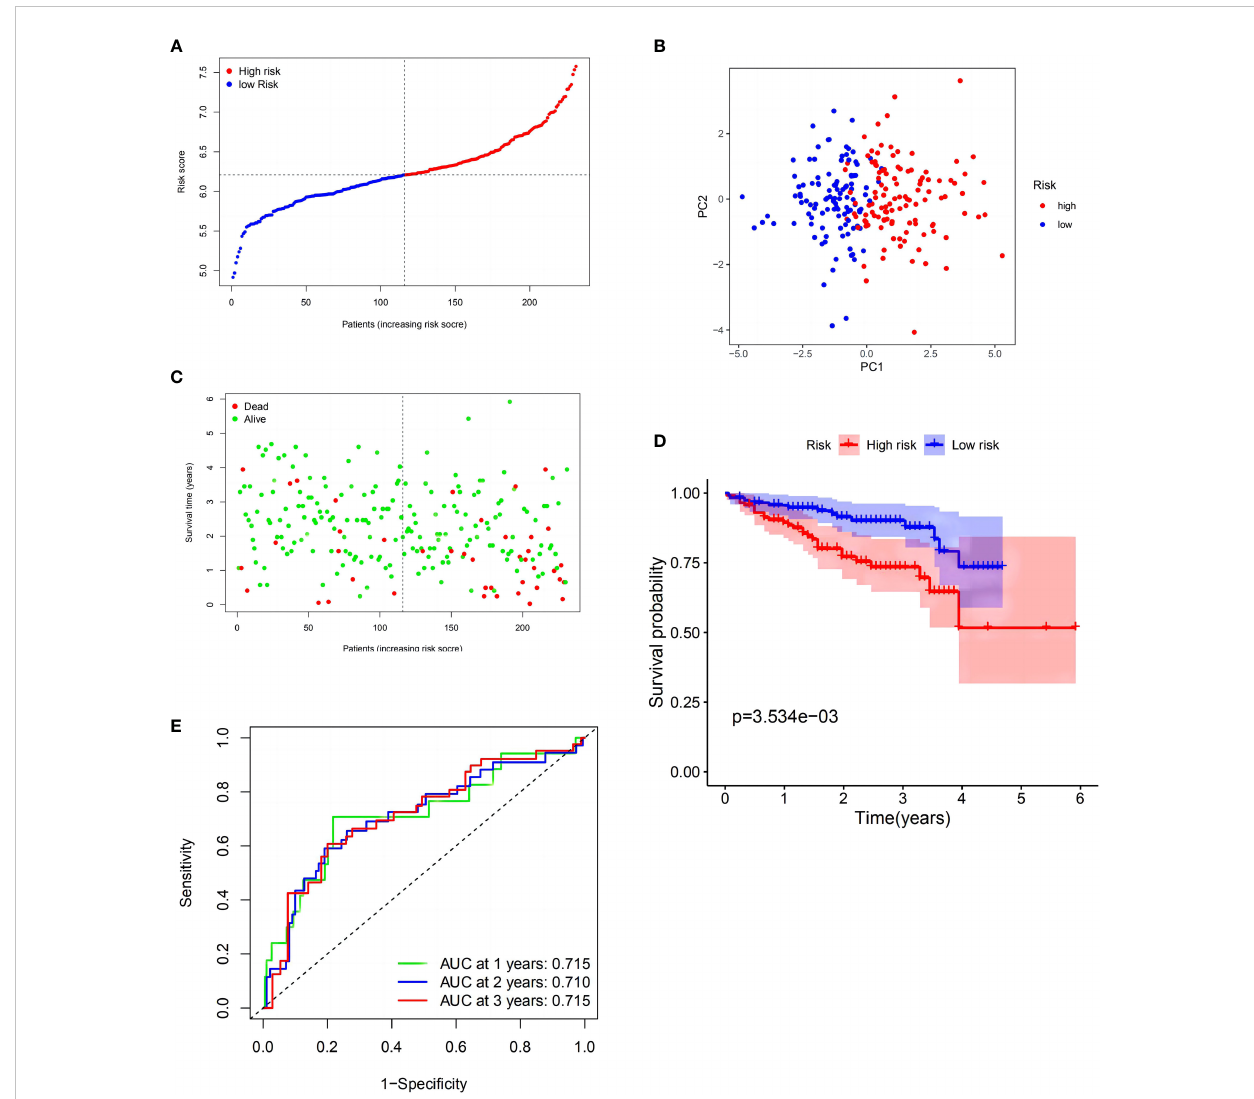
FIGURE 3 Validation of the risk model in the International Cancer Genome Consortium (ICGC) cohort. (A) Distribution of patients in the ICGC cohort based on the median risk score in the TCGA cohort. (B) PCA plot for HCCs. (C) Survival status for each patient (low-risk population: on the left side of the dotted line; high-risk population: on the right side of the dotted line). (D) Kaplan – Meier curves comparingOS between the low- and high-risk groups. (E) Time-dependent ROC curves for